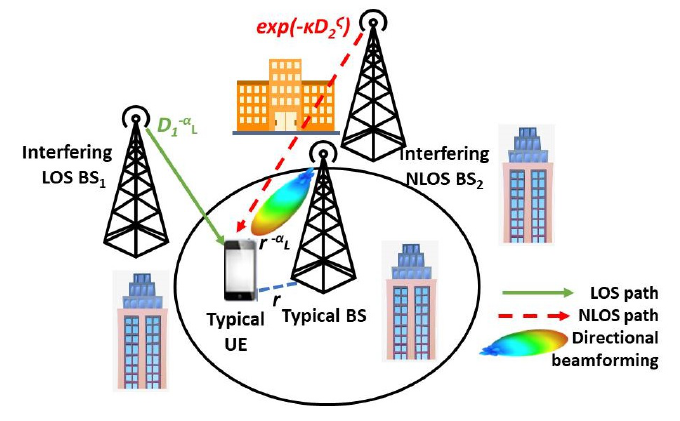
Figure 1. Downlink mmwave system model with exponential attenuation in the NLOS